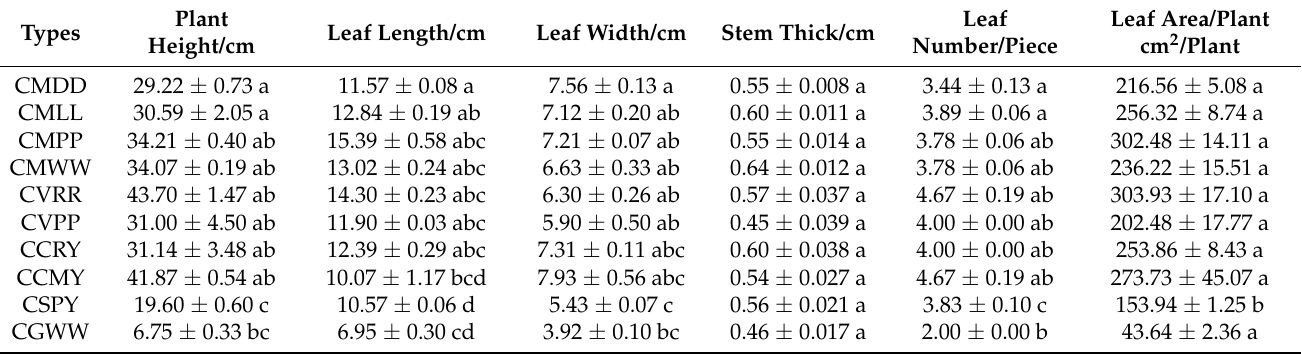
Table 2. Morphological characteristics of 10 Cypripedium samples, including plant height, leaf length, leaf width, stem thickness, leaf number, and leaf